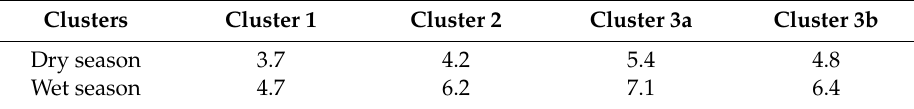
Table 5. Water Quality Index for aquatic life (WQIal) in An